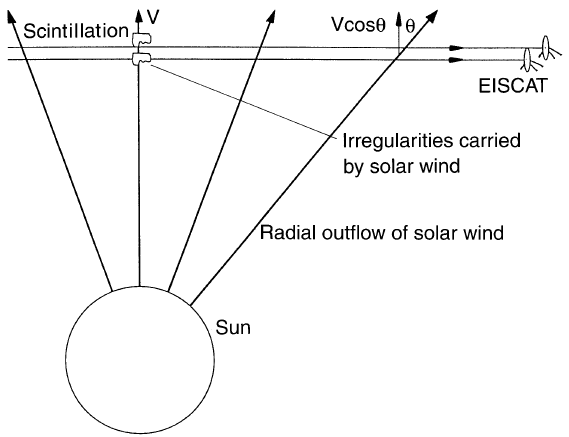
Fig. 1. Schematic diagram of EISCAT IPS observations (SP-UK- SCINTI). Density fluctuations carried outwards by the solar wind modulate the radio waves from the distant source, producing a mov- ing interference pattern at the receiving sites. The experiment is only sensitive to the component of solar wind velocity perpendicular to the line of sight to the source ( » cos (cid:104) , where » is the solar wind